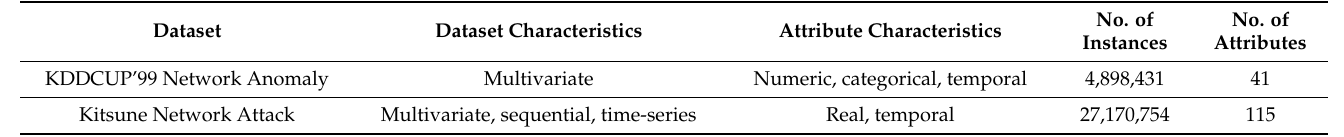
Table 1. Datasets’ description.